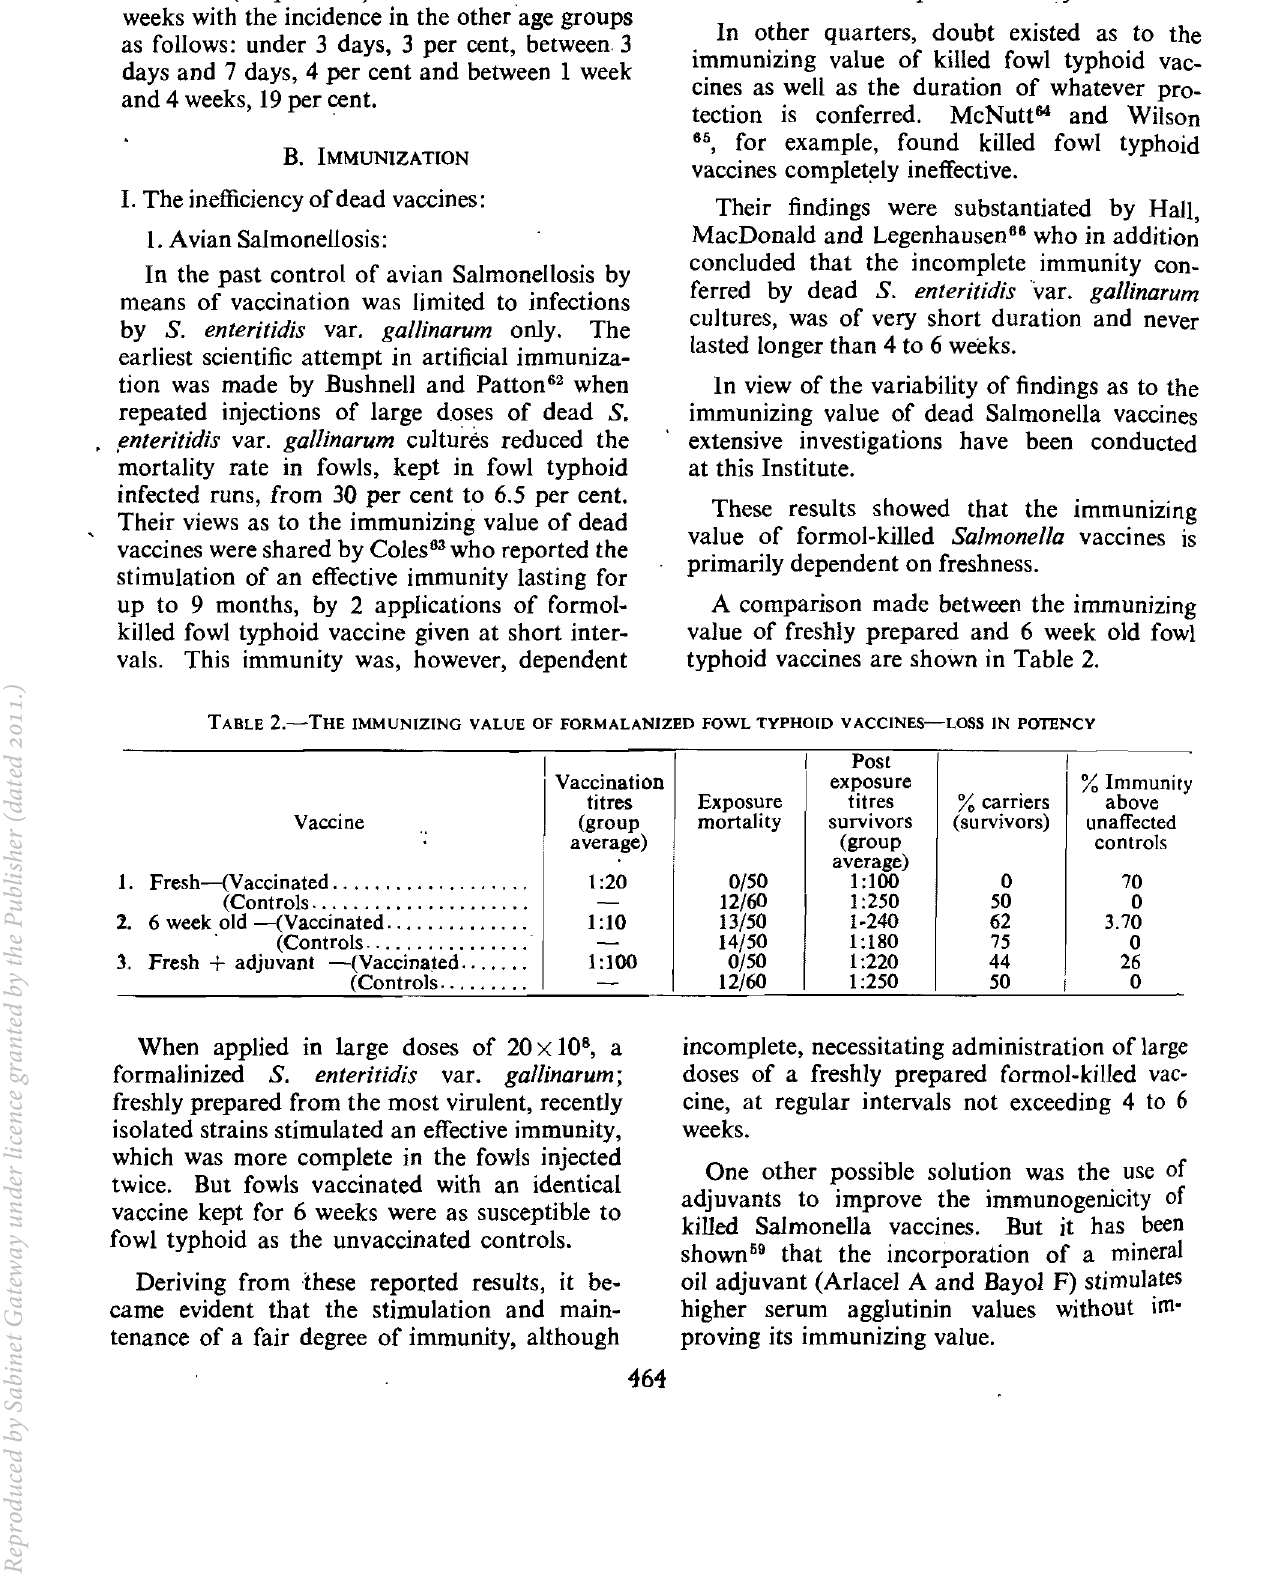
TABLE 2.- THE IMMUNIZING VALUE OF FORMALANIZED FOWL TYPHOID VACCINES-LOSS IN POTENCY I